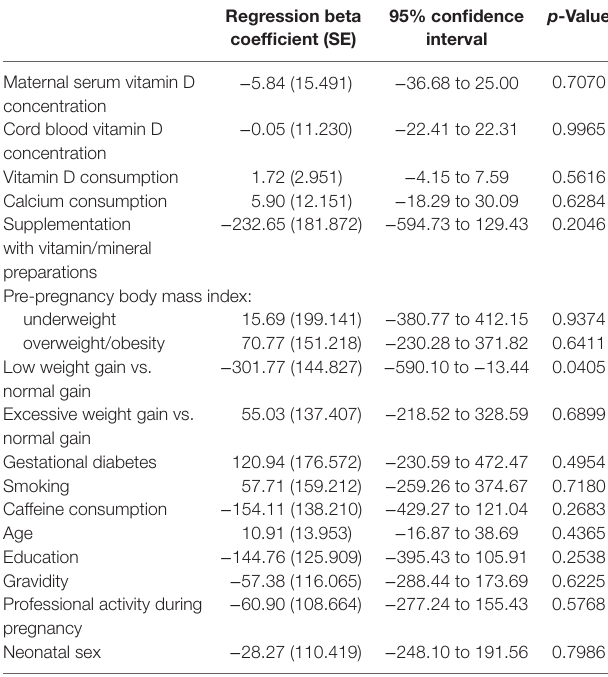
TaBle 2 | Relationship between selected parameters and neonatal weight.